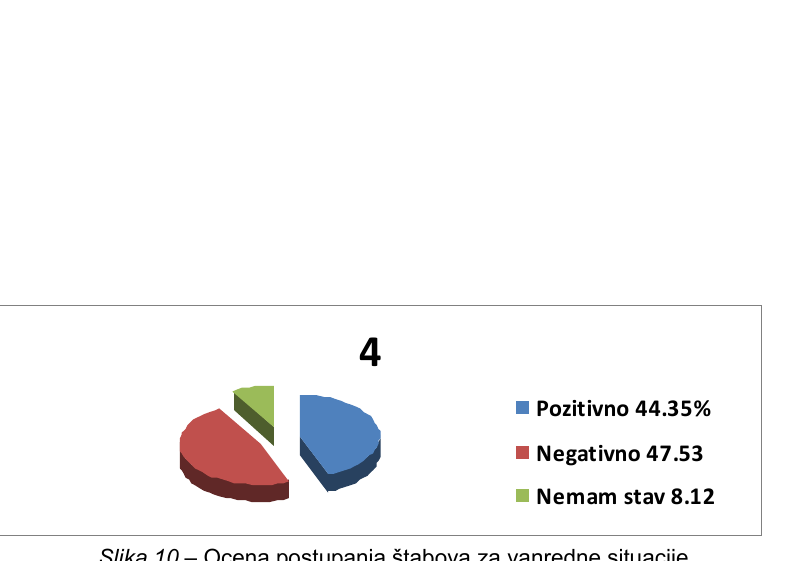
Figure 10 – Rating of the actions of the Staff for Emergencies